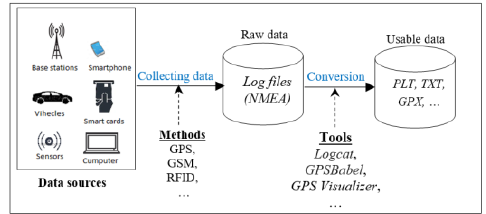
Figure 2 . Process of usable data production in smart city